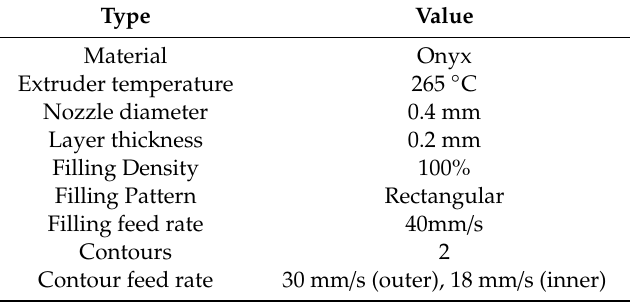
Figure 2. Vibration sensors based in-situ monitoring and diagnosing system during the FFF process. Table 1. Specification of the FFF process.